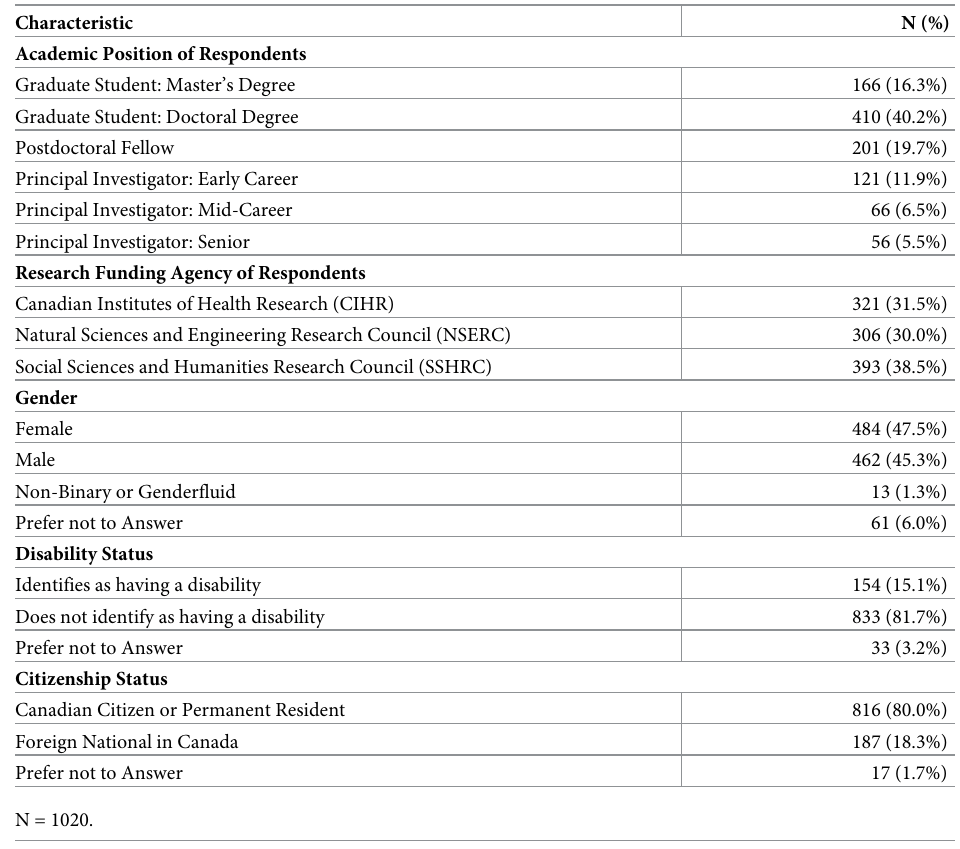
Table 1. Survey respondent